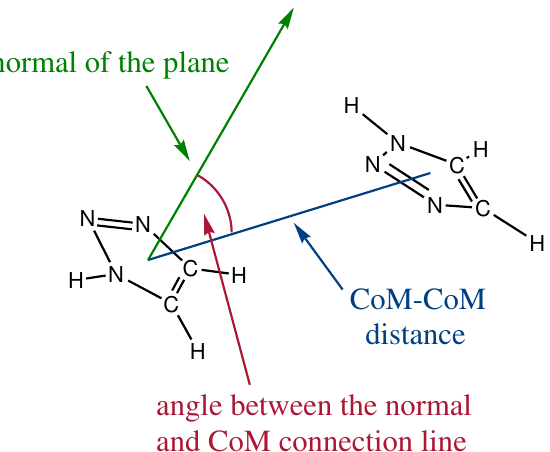
Figure 1. Definition of the criterion for π - π stacking. If the angle between the normal of the plane and the line between the two ring center of masses is zero than both molecules are parallel to and above each other. If the angle is 90 ◦ , it refers to T-shaped π - π stacking or a hydrogen